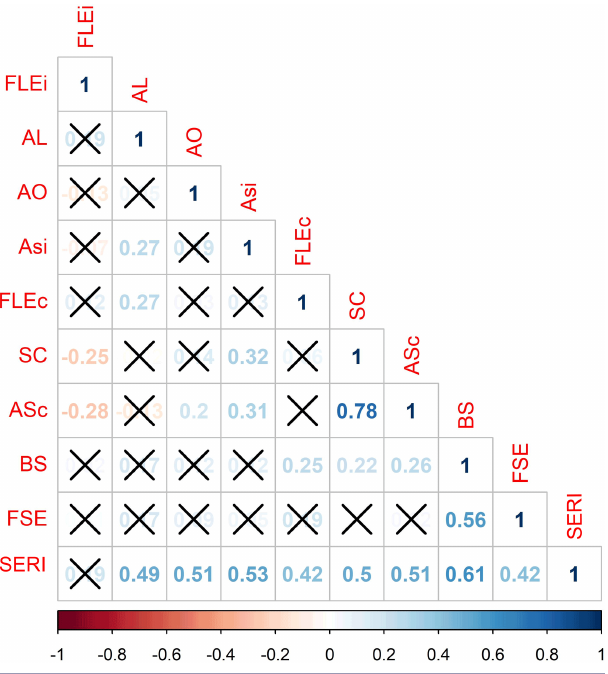
Fig. 4 . Correlation matrix between the index of social- ecological resilience of fishers and the variables inputted in the composite index. The values marked with X mean that these are the nonsignificant values. FLEi = flexibility at the individual level, AL = ability to learn, AO = ability to organize, ASi = assets at the individual level, FLEc = flexibility at the community level, SC = social capital, ASc = assets at the community level, BS = biological sensitivity, FSE = fish species exposure, SERI = social-ecological resilience index.